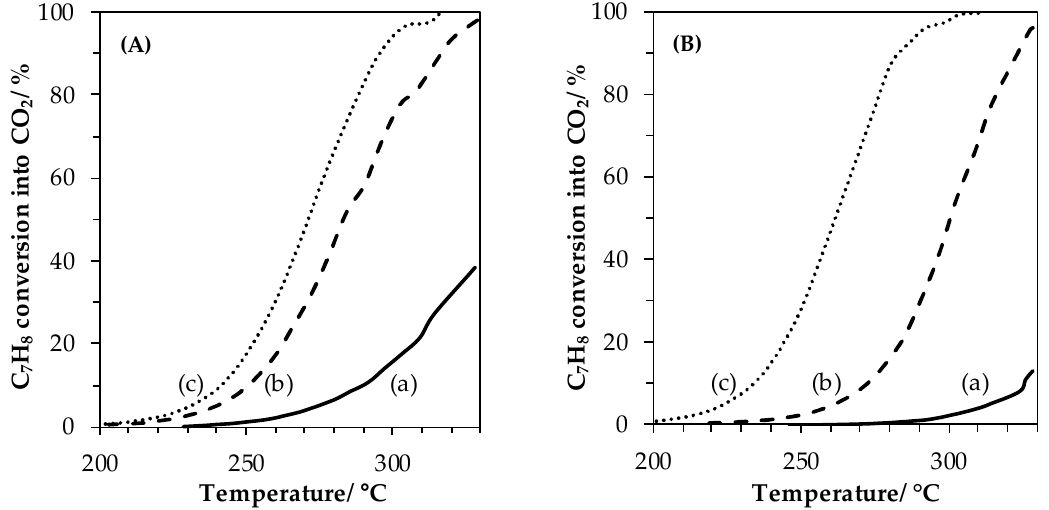
Figure 7. Toluene conversion curves obtained for LaMnO 3.15 ( A ) and LaFeO 3 ( B ) samples: (a) SSR, solid state reaction; (b) HEBM, high-energy ball milling; (c) LEBM, low-energy ball milling. Conditions: 200 mg of catalyst, 100 mL · min − 1 of 1000 ppmv C 7 H 8 in synthetic air (20% O 2 in N 2 ).